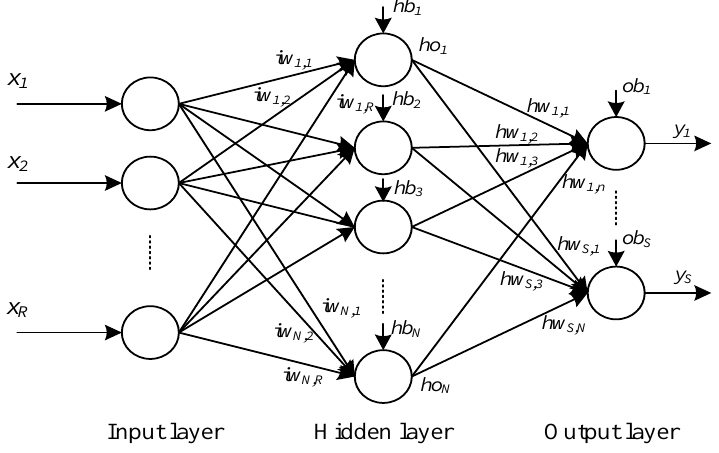
Figure 4. A feed-forward network with three layers.